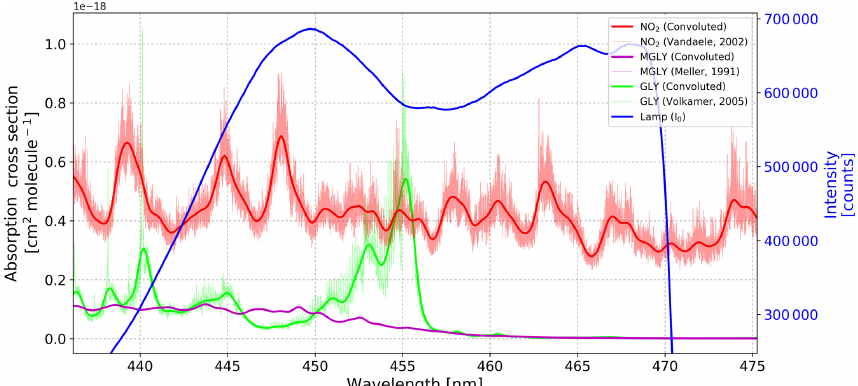
Figure 2. Reference spectrum of the IBBCEAS system (blue) and absorption cross sections of NO 2 , GLY, and MGLY. The thin lines are the high-resolution cross sections documented in the literature, and the thick lines are the cross sections after processing with the instrument function determined by the Fraunhofer reference spectrum (Kurucz et al., 1984).